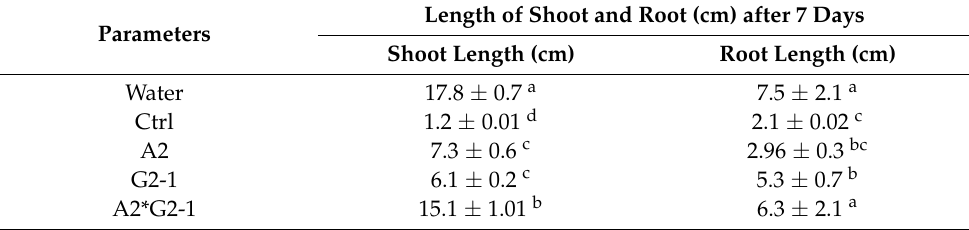
Table 4. Phytotoxicity study of different textile wastewater on soybean seeds using the two fungal strains and their